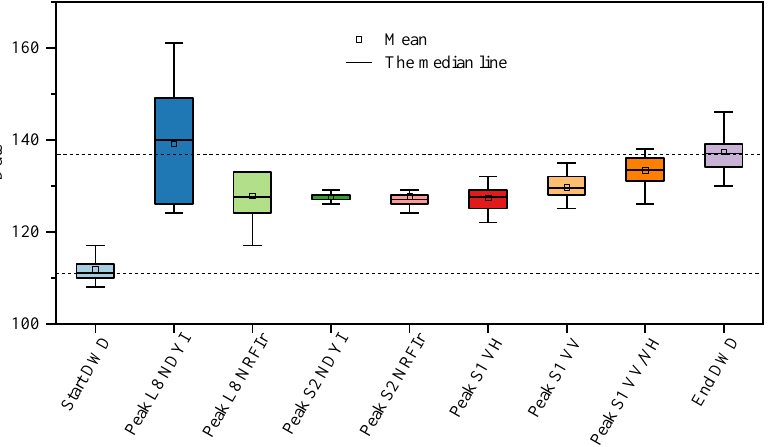
Figure 7. Comparing the peak flowering dates of rapeseed identified by different indexes with the flowering starts (BBCH61) and ends (BBCH69) observed at DWD stations.